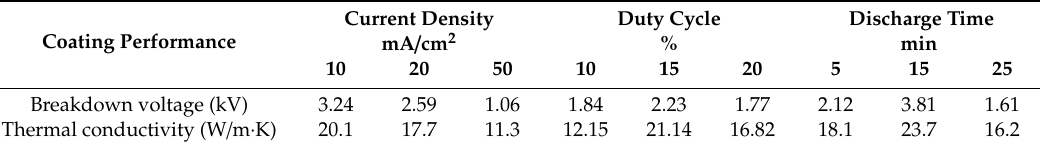
Table 6. The breakdown voltage and thermal conductivity of APD coating at di ff erent conditions. Coating Performance